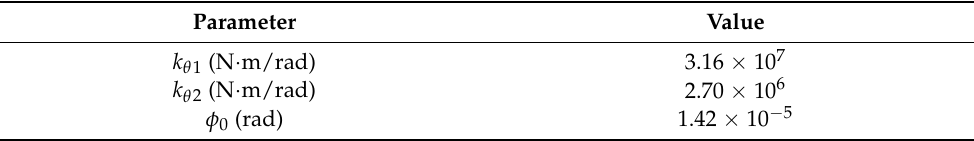
Table 1. Stiffness and critical rotation angle of bolted joints.